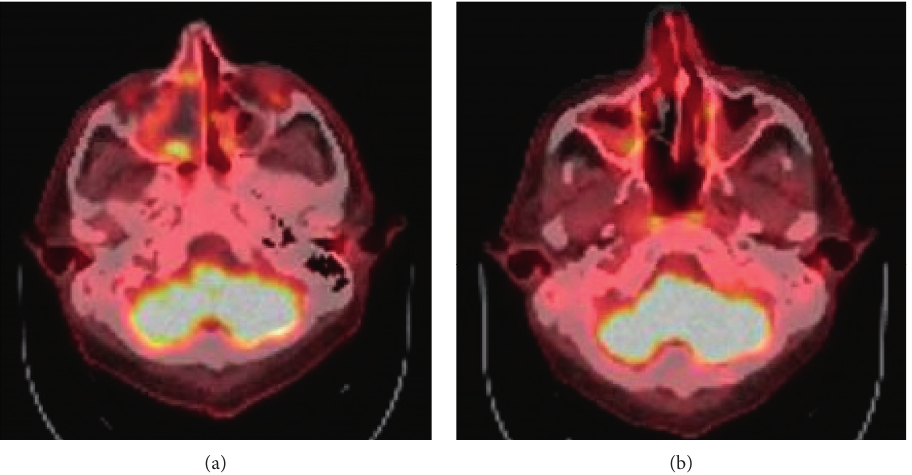
Figure 3: PET/CTscan highlighting the maxillofacial structures. (a) After 2 cycles of mSMILE, a single 1.1 cm focus of increased FDG uptake was seen along the right sinonasal cavity, SUV max 9.3. (b) Restaging PET/CTscan after 6 cycles of mSMILE showing mild residual uptake in the right maxillary sinus, SUV max 4.2.